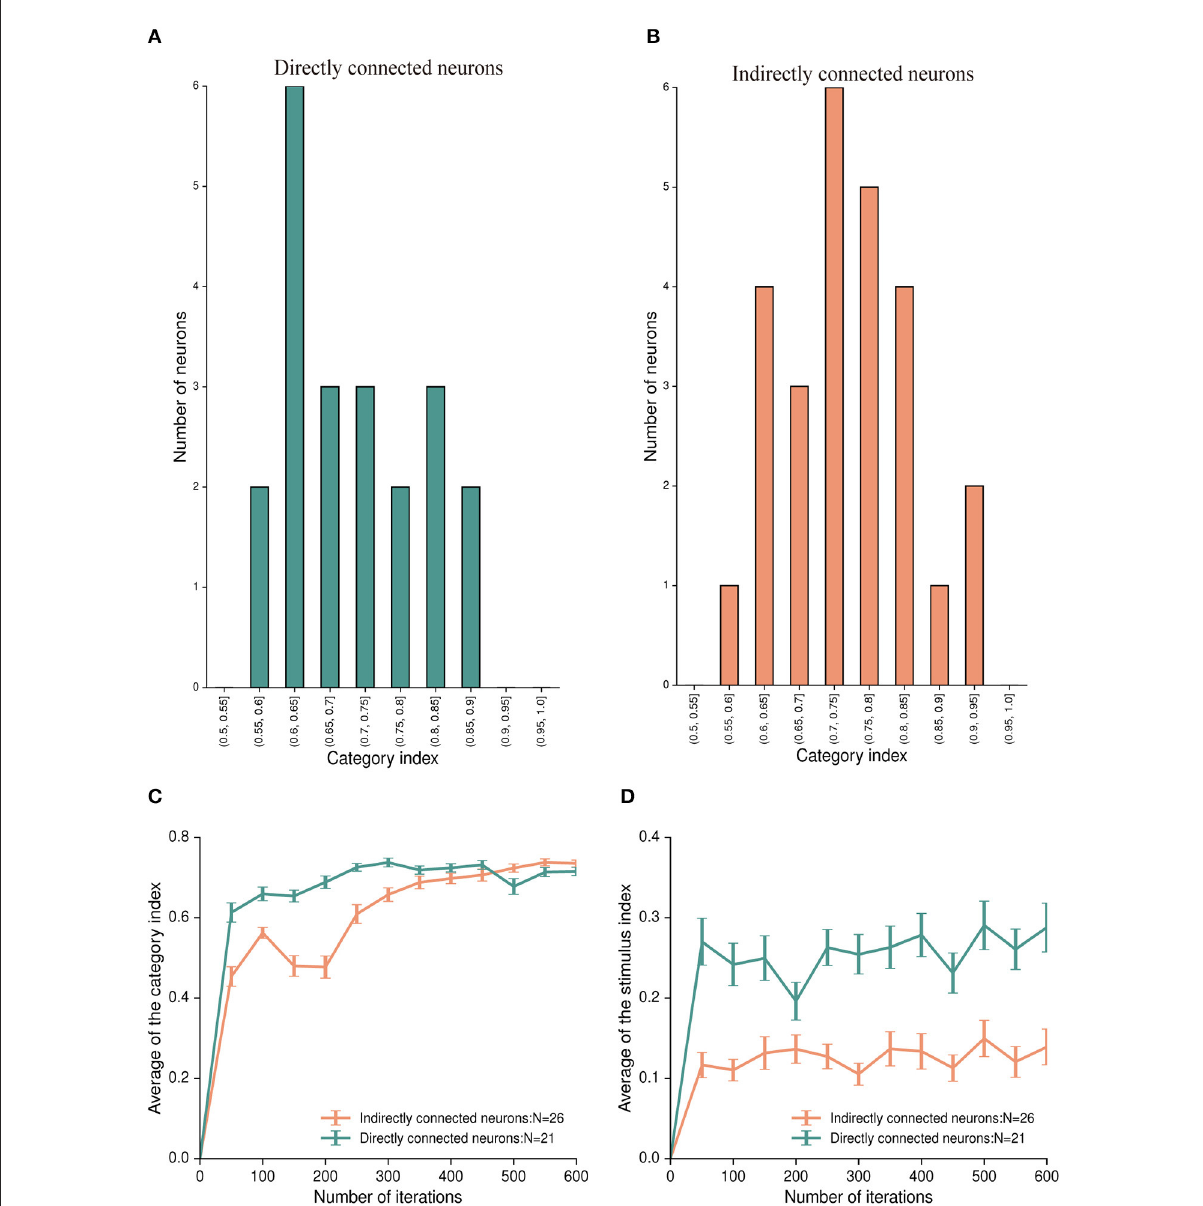
FIGURE7 Category index and stimulus index for two types of category-neurons: directly connected neurons and indirectly connected neurons. (A) The distribution of category indexes of 21 category-neurons, which have direct connections from the input layer. The range of category index for these neurons is from 0.5 to 0.9. (B) The distribution of category indexes of 26 category-neurons, which have no direct connections from the input layer. The range of category index for these neurons is from 0.5 to 1. (C) The time course of category index for the directly connected neurons (the aquamarine curve) and the indirectly connected neurons (the salmon curve), respectively. (D) The time course of the stimulus index for the directly connected neurons (the aquamarine curve) and the indirectly connected neurons (the salmon curve),